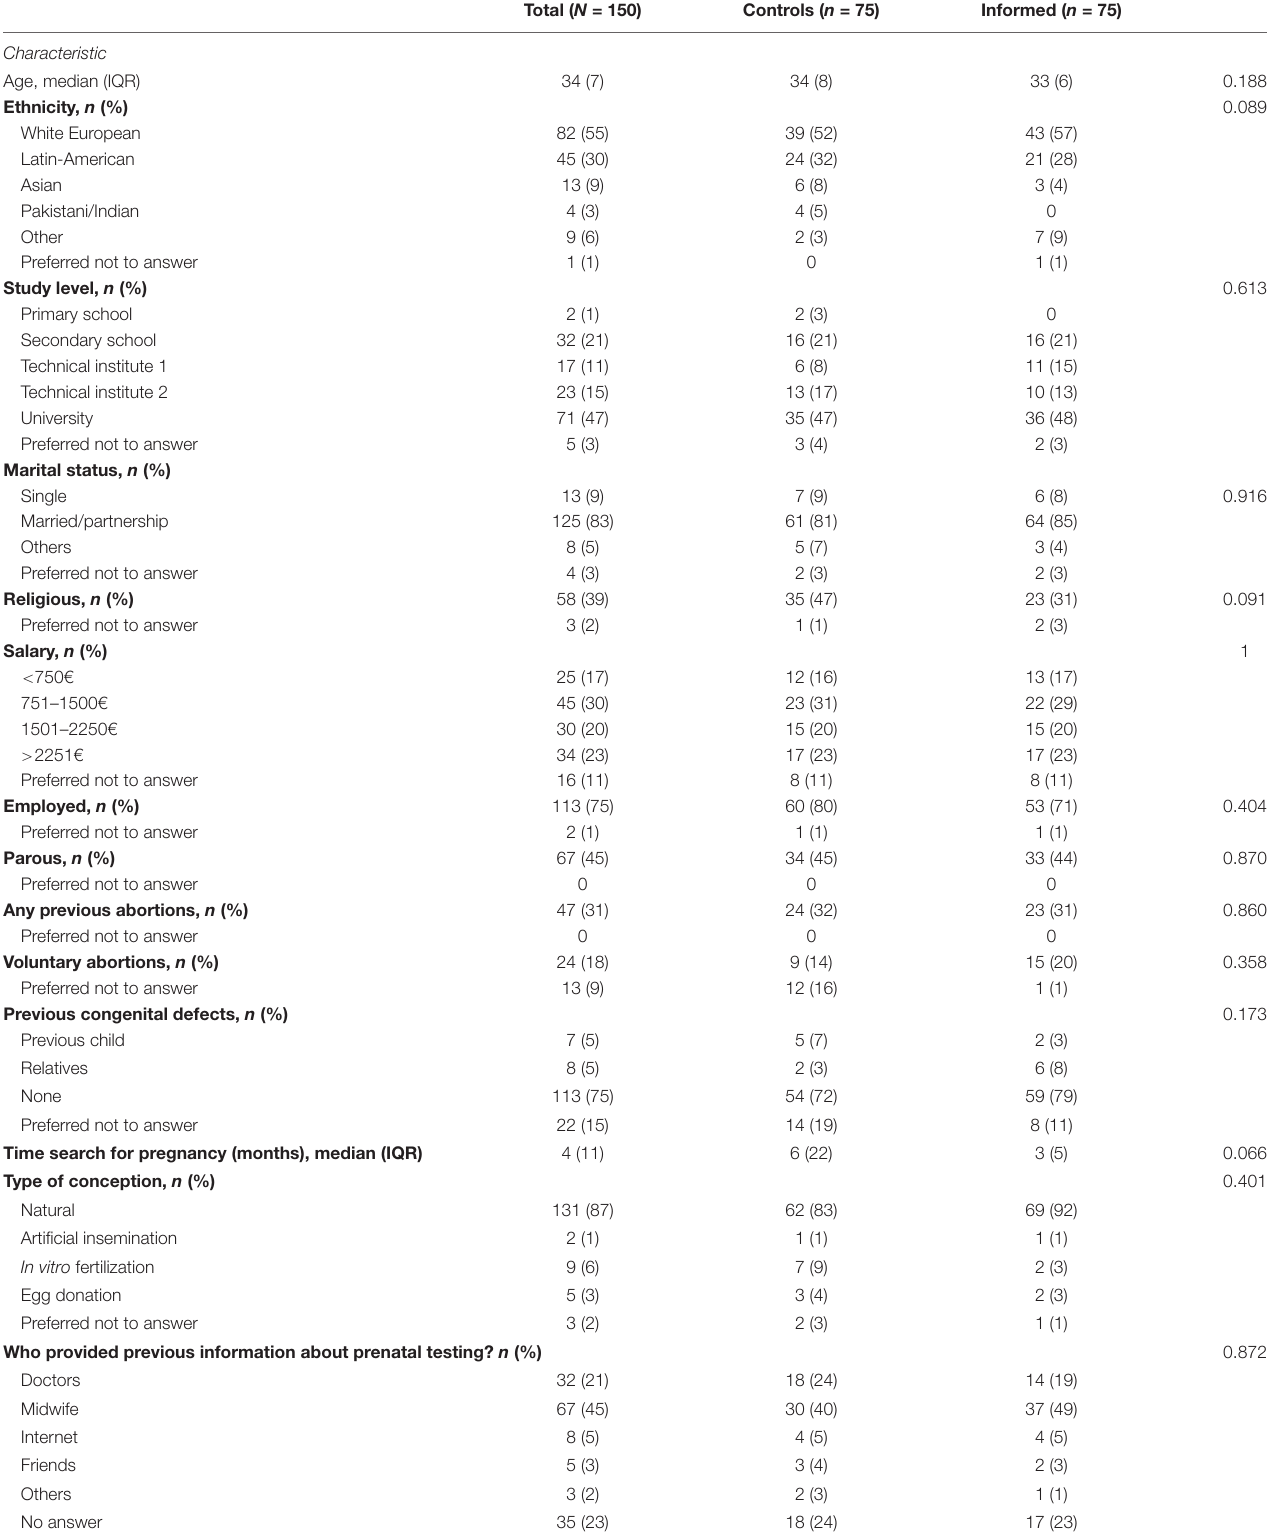
TABLE 1 | Characteristics of the included